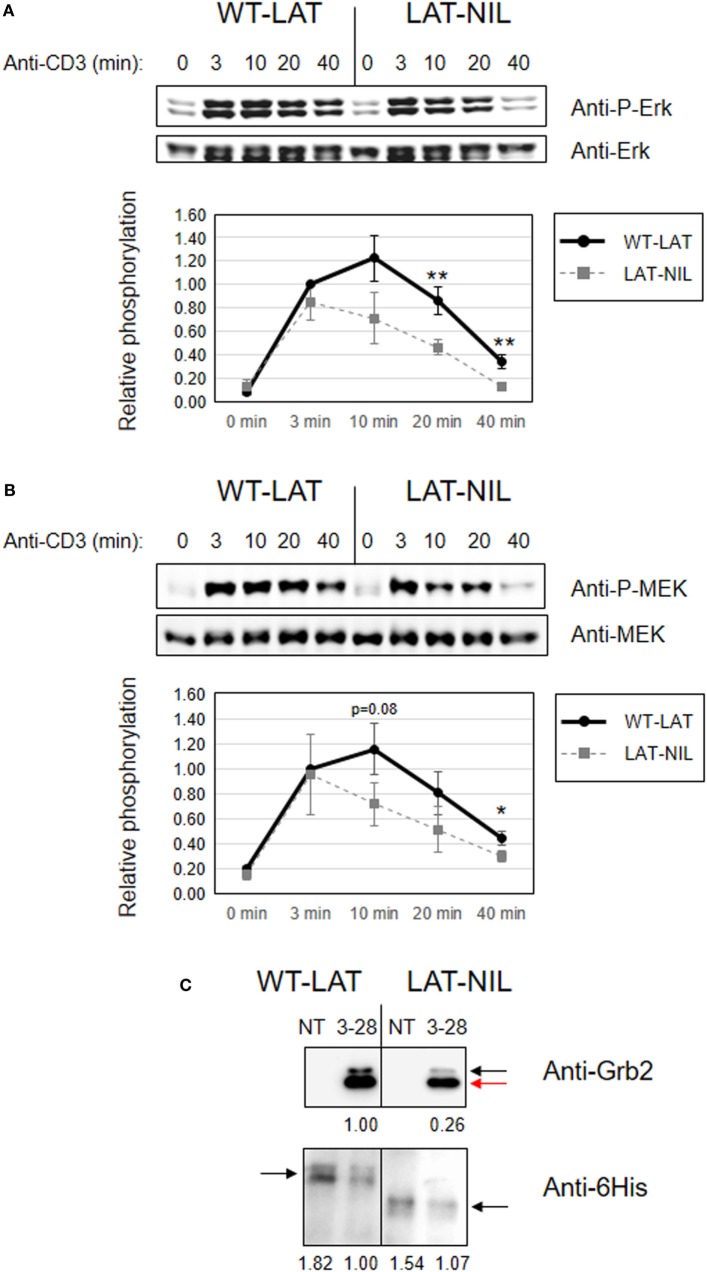
Negative impact of linker for activation of T cell (LAT)-NIL expression on MAPK pathway activation. JCaM2 cells expressing WT-LAT or the LAT-NIL mutant were stimulated at 37°C with anti-CD3 antibody for the indicated times. (A) Whole-cell lysates were probed by Western blotting for the activation of Erk by using a mAb recognizing doubly phosphorylated on specific threonine and tyrosine residues on Erk (upper panel). Stripped membranes were blotted with anti-pan Erk mAb to show equal protein expression (middle panel). Densitometric quantification of six independent experiments is shown in the lower diagram, representing mean fold increase in Erk phosphorylation for J.CaM2 cells expressing WT-LAT (thick continuous line) or the LAT-NIL mutant (thin dashed line). Phosphorylation levels were normalized to total Erk expression. (B) Whole-cell lysates were assayed for MEK1/2 activation with a mAb detecting specifically phosphorylation of Ser221. Stripped membranes were also blotted with anti-pan MEK1/2 mAb to show equal protein expression. Lower diagram represents the mean fold increase of MEK phosphorylation in five independent experiments. Bars represent the standard error. Asterisks represent statistical significance. (C) 107 J.CaM2 cells expressing either WT-LAT or the LAT-NIL mutant were left untreated (NT) or stimulated for 5 min with 10 µg of anti-CD3 plus 10 µg of anti-CD28 antibodies, and postnuclear lysates were subjected to LAT immunoprecipitation with an anti-LAT antibody. The precipitates were analyzed by Western blot with an anti-Grb2 antibody (upper panel) or an anti-6His antibody (lower panel), as indicated. Images are representative of three independent experiments. Numbers below the blots indicate the densitometric quantification of the corresponding bands. Black arrow in the upper blot indicates the band corresponding to Grb2, and the red arrow indicates the position of the light chains. Black arrows in the lower blot indicate the position of LAT.